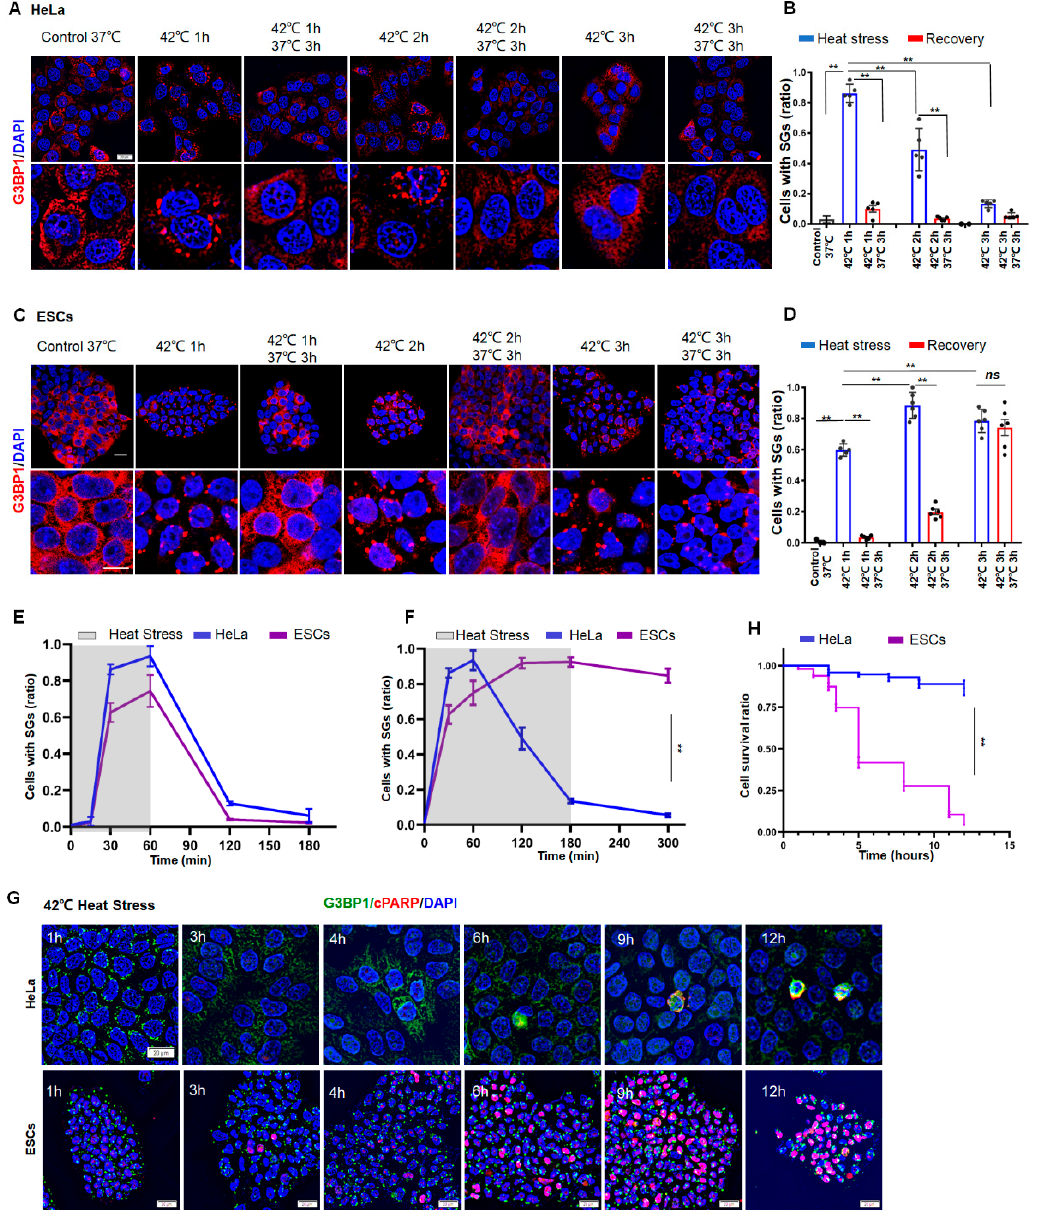
Figure 1. SG Dynamics and cell death in HeLa or ESCs under prolonged stress. ( A , B ) SGs in HeLa cells under 42 °C stress for 1, 2, or 3 h, respectively. Scale bar, 20 μ m. Mean ± SEM. ** p < 0.01 (ANOVA test). ( C , D ) SGs in ESCs under 42 °C stress for 1, 2, or 3 h, respectively. Scale bar, 20 μ m. Mean ± SEM. ** p < 0.01 (ANOVA test). ( E ) Statistical analysis of G3BP1-SGs in HeLa cells or ESCs after 42 °C stress for 1 h then recovery for 2 h at 37 °C. Mean ± SEM. ( F ) Statistical analysis of G3BP1-SGs in HeLa cells or ESCs after 42 °C stress for 3 h, followed by recovery for 2 h at 37 °C. Mean ± SEM. ** p < 0.01 (ANOVA test). ( G , H ) cPARP staining and cell survival ratio in HeLa or ESCs under prolonged stress. Scale bar, 20 μ m. Mean ± SEM. ** p < 0.01 (ANOVA test). 3.2. HeLa Cells Can Resolve SGs while ESCs Fail to Do So Due to Low Levels of HSP70